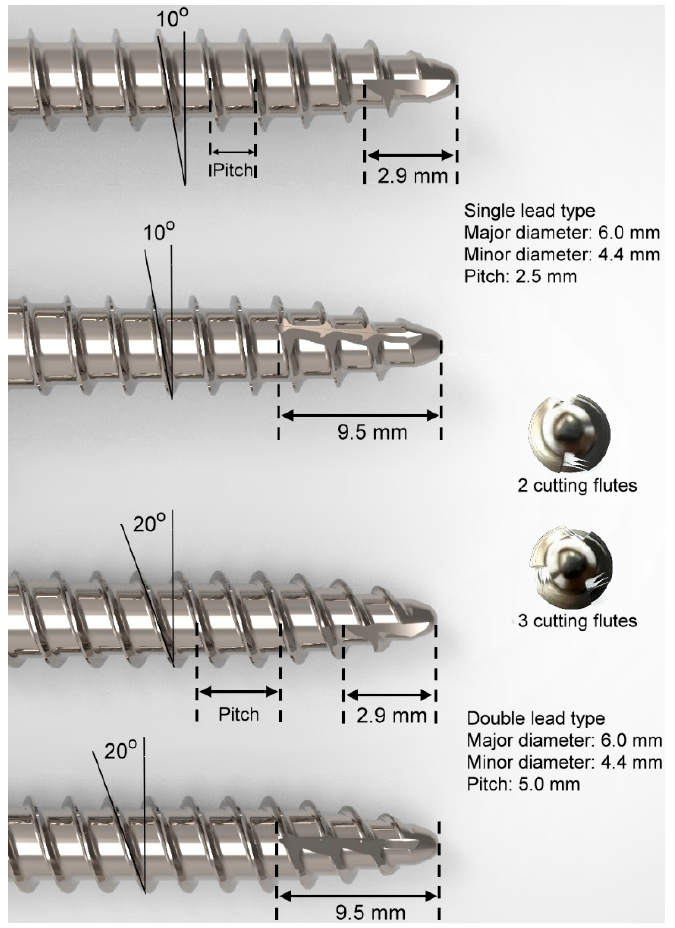
Figure 1. Screws with varying leads of thread and cutting flute length. A differential screw uses a spindle with two screw threads of differing leads, a single-lead means equal to the thread pitch and double-lead means twice the thread pitch. Major diameter is the diameter at the thickest part of the thread. Minor diameter is the thickness at the base of the screw.